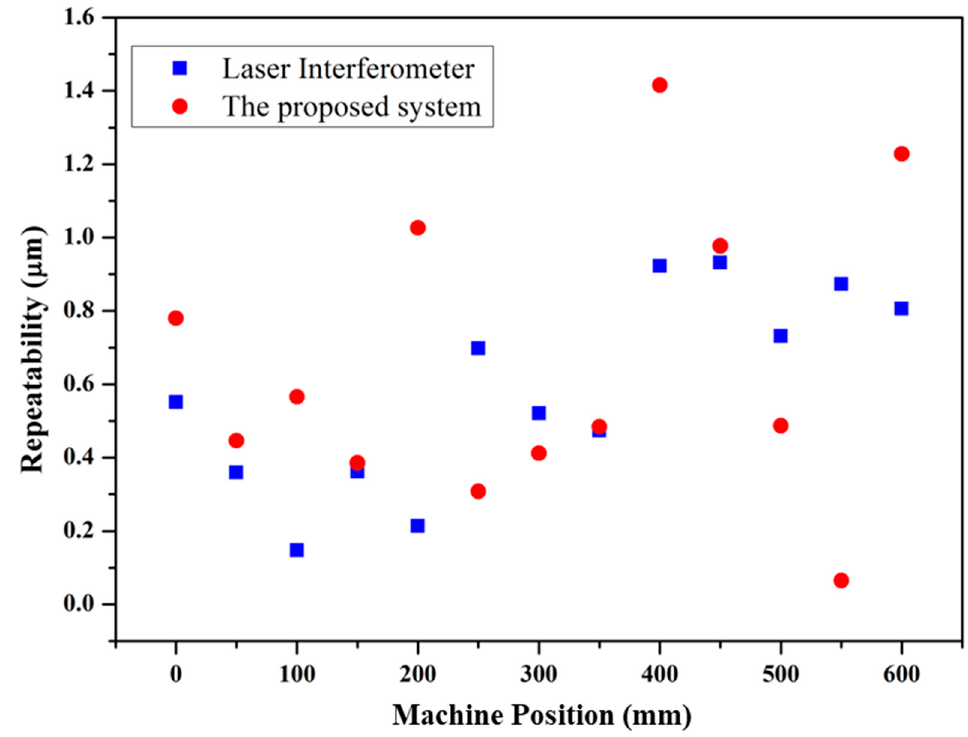
Figure 11. Verification setup of dual-axis measurements. Figure 13. Repeatability of single-axis measurement verification. Figure 13. Repeatability of single-axis measurement verification. Figure 13. Repeatability of single-axis measurement verification.